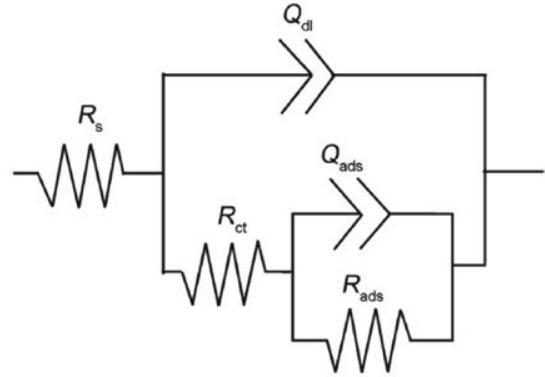
Figure 9. Equivalent circuit compatible with the experimental im- pedance data in Figures 8 for ethanol electro-oxidation on Ni-Cu